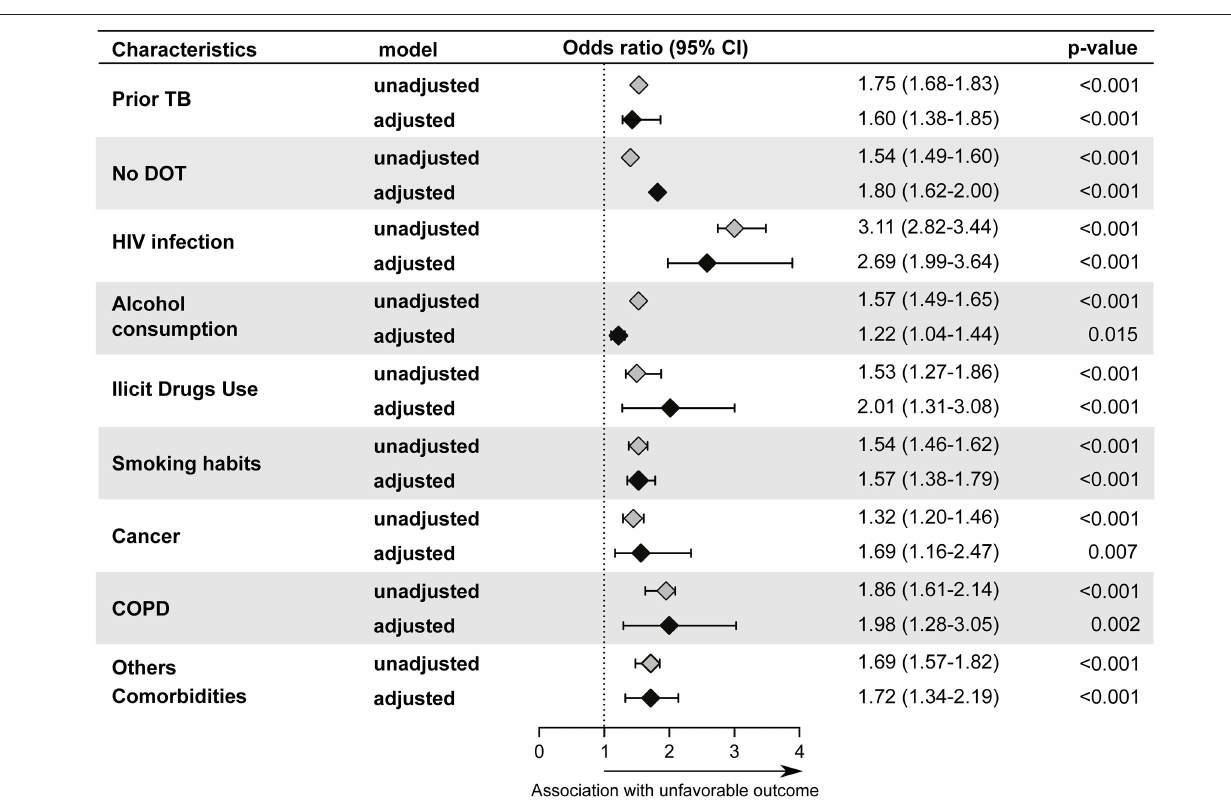
FIGURE 6 | Backward stepwise logistic regression model test independent associations between all the relevant clinical and epidemiological parameters and treatment outcome in elderly group ( ≥ 65 years). The unfavorable outcome was used as reference to test associations. Only parameters which remained with p < 0.05 in in the adjusted model (95%CI: 95% confidence interval) were plotted. Adjustment was performed for each parameter: race (reference: indigenous); male (reference: female); illiterate(reference: literate); prior TB (reference: new case); no DOT (reference: DOT indication); Pulmonary TB (reference: Pulmonary and Extrapulmonary TB); Extrapulmonary TB (Reference: Pulmonary and Extrapulmonary TB); Pulmonary and Extrapulmonary TB (reference: Pulmonary TB); HIV infection (reference: without HIV infection); Alcohol Consumption (reference: no alcohol consumption); Diabetes (reference: no diabetes); Illicit drug use (reference: no illicit drug use); Smoking habit (reference: no smoking). Cancer (reference: no condition); COPD (reference: no condition); Kidney disease (reference: no condition); Hypertension (reference: no condition); Other comorbidities (reference: no condition); Abnormal chest X-ray (reference: normal chest X-ray). TB, tuberculosis; DOT, directly observed treatment; COPD, chronic obstructive pulmonary disease; Other comorbidities: It did not include HAS, kidney disease, cancer, and